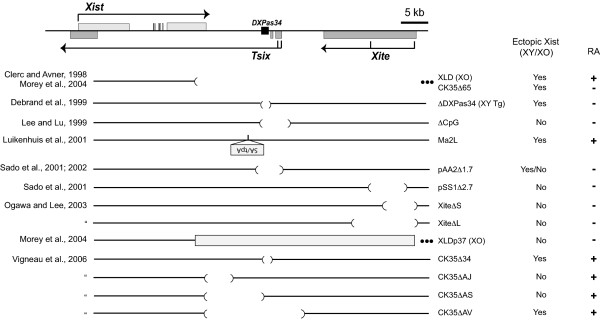
Summary of Xist phenotypes in Tsix-mutant male ES cell lines. All mutant ES cell lines are XY diploid male (except where noted) and listed with the names used in the original references. XY Tg, male transgenic line; shaded rectangle represents the 37-kb region re-inserted into a deleted locus; •••, extends beyond the Xic diagram depicted; RA, retinoic acid. SA/tpA, please refer to cited references for details. The 'yes/no' designation for pAA2Δ1.7 refers to the very low number of Xist-positive cells and the fact that there is no excessive cell death or inviability reported in these cells or mice. Differentiation in the presence (+) or absence (-) of retinoic acid is indicated.